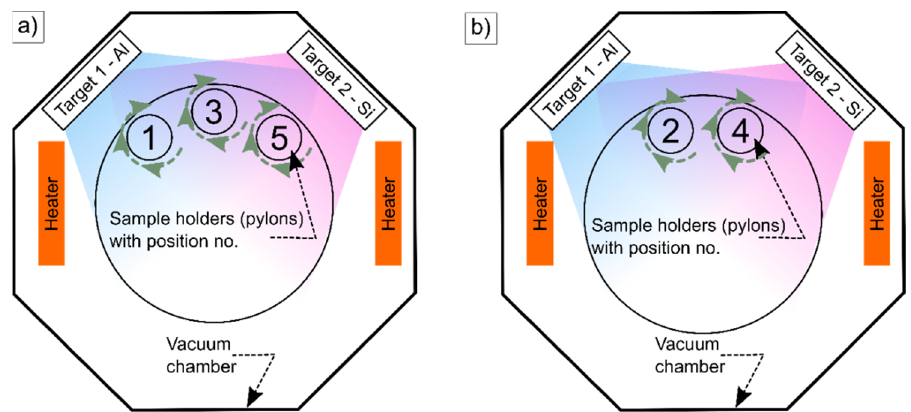
Figure 1. Schematic of the IMPAX coater with the different settings for the combinatorial deposition of the different Al-Si coatings. Setup ( a ) was used for the deposition of the Al-1Si, Al-12Si, Al-78Si and Al-81Si coatings, whereas setup ( b ) produced the Al-2Si, Al-3Si, Al-58Si and Al-64Si coatings. Different power was used for the Al target (3 kw) and Si target (1.2 kW) in order to reproduce the Al-18Si paper (in at.%) of a previous work [32] at position 3. However, due to shadowing effects of the additional pylons on positions 1 and 5, the Si content was only 12 at.%. In this work, two runs in total were conducted to produce the 8 compositions (1st run: Figure 1a; 2nd run: Figure 1b). Between Al-12Si and Al-58Si, a larger gap of compositions occurred, which was due to the sample positioning and shadowing.